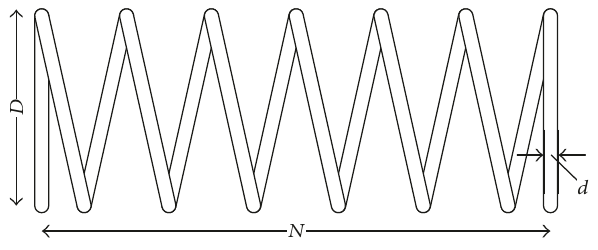
Figure 41: The tension/compression spring design problem.